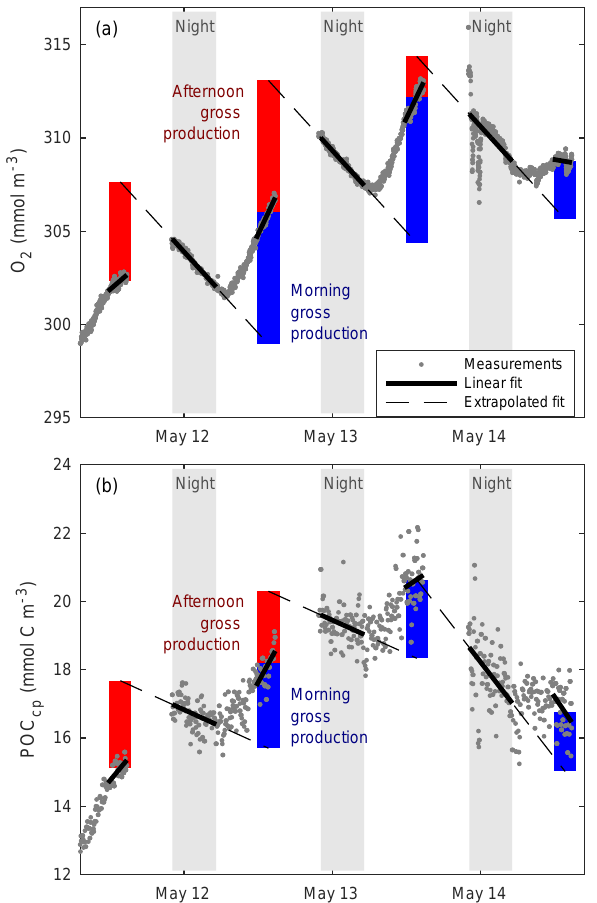
Figure 4. Calculation of the gross production of O 2 (a) and POC cp (b) in the ML from their diel